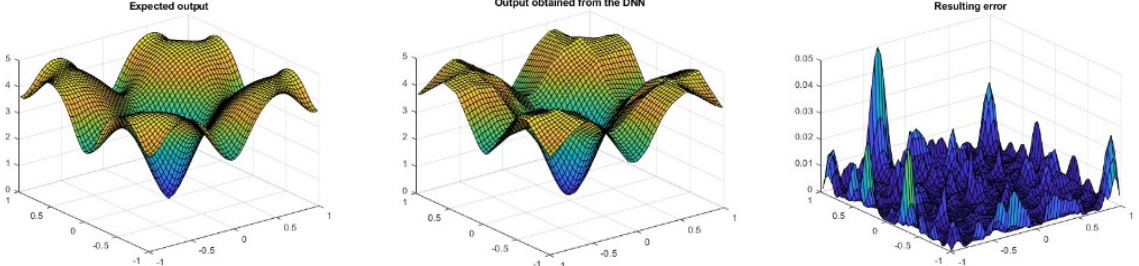
Figure 20. Expected output of the DNN for the Ackley function on the left, the obtained results in the middle and the error on the right.